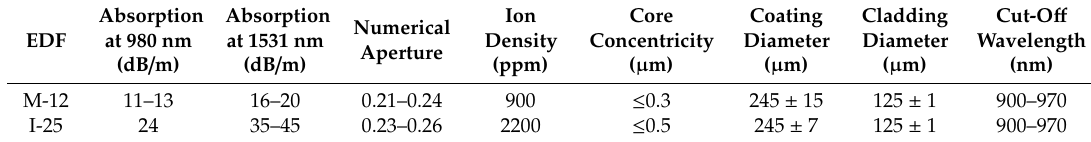
Table 1. Main characteristics of tested highly doped erbium fibers